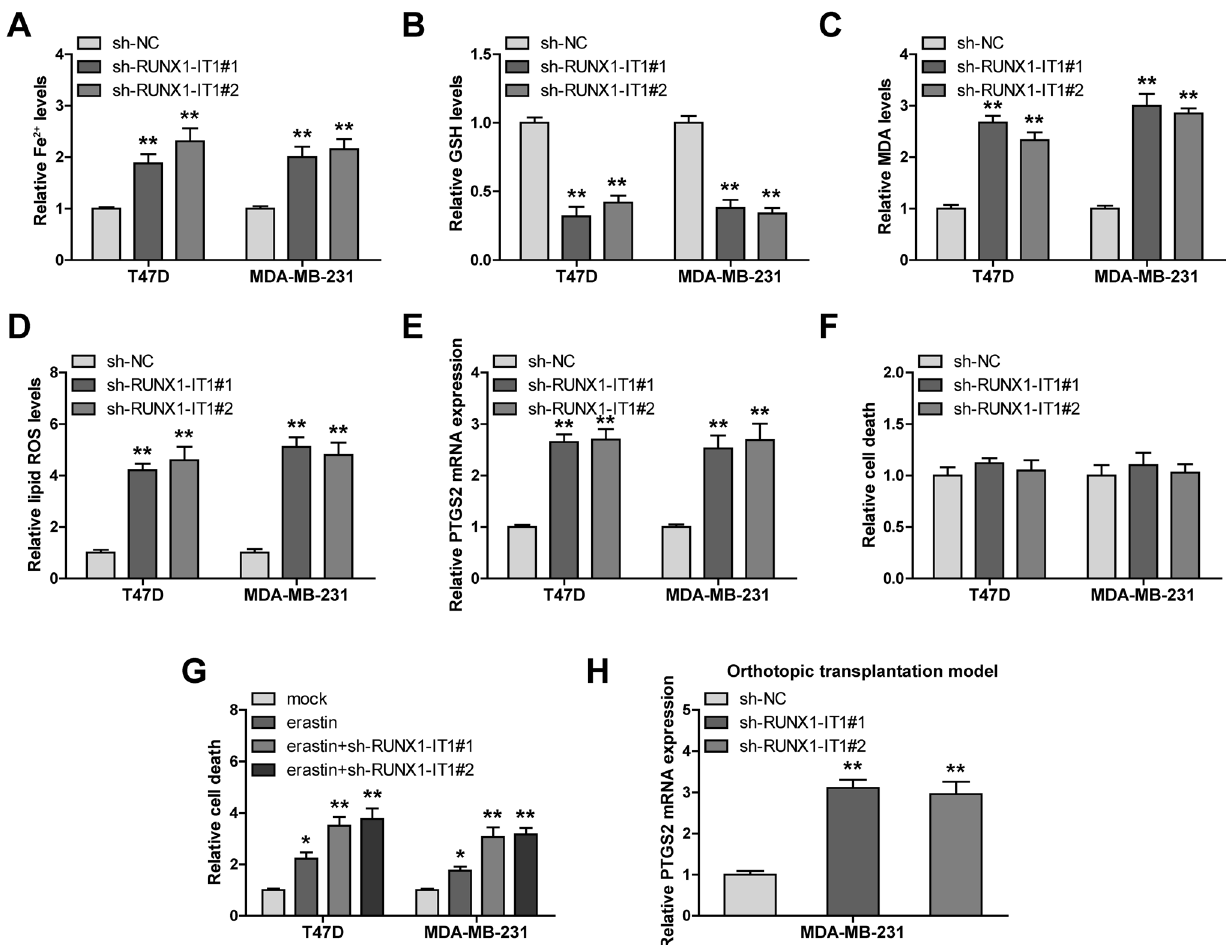
Fig. 3 RUNX1-IT1 inhibits ferroptosis. A – D The levels of Fe 2+ , GSH, MDA and lipid ROS were tested after RUNX1-IT1 knockdown. E qRT-PCR analysis of PTGS2 mRNA levels in RUNX1-IT1-silenced cells. F , G PI staining testing cell death in RUNX1-IT1-silenced cells. H qRT-PCR analysis of PTGS2 mRNA levels in tumors bearing RUNX1-IT1-silenced MDA-MB-231 cells. * P < 0.05, ** P <